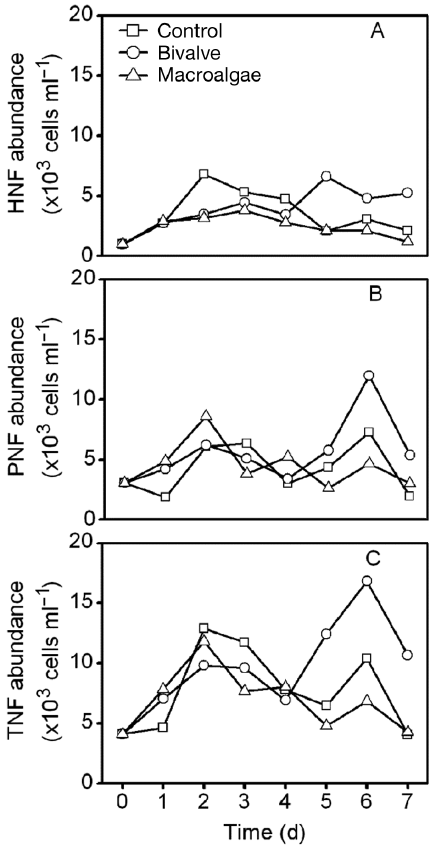
Fig. 8. Variations in abundance of (A) heterotrophic nano- flagellates (HNF), (B) pigmented nanoflagellates (PNF) and (C) total nanoflagellates (TNF) in the enclosure experiments over